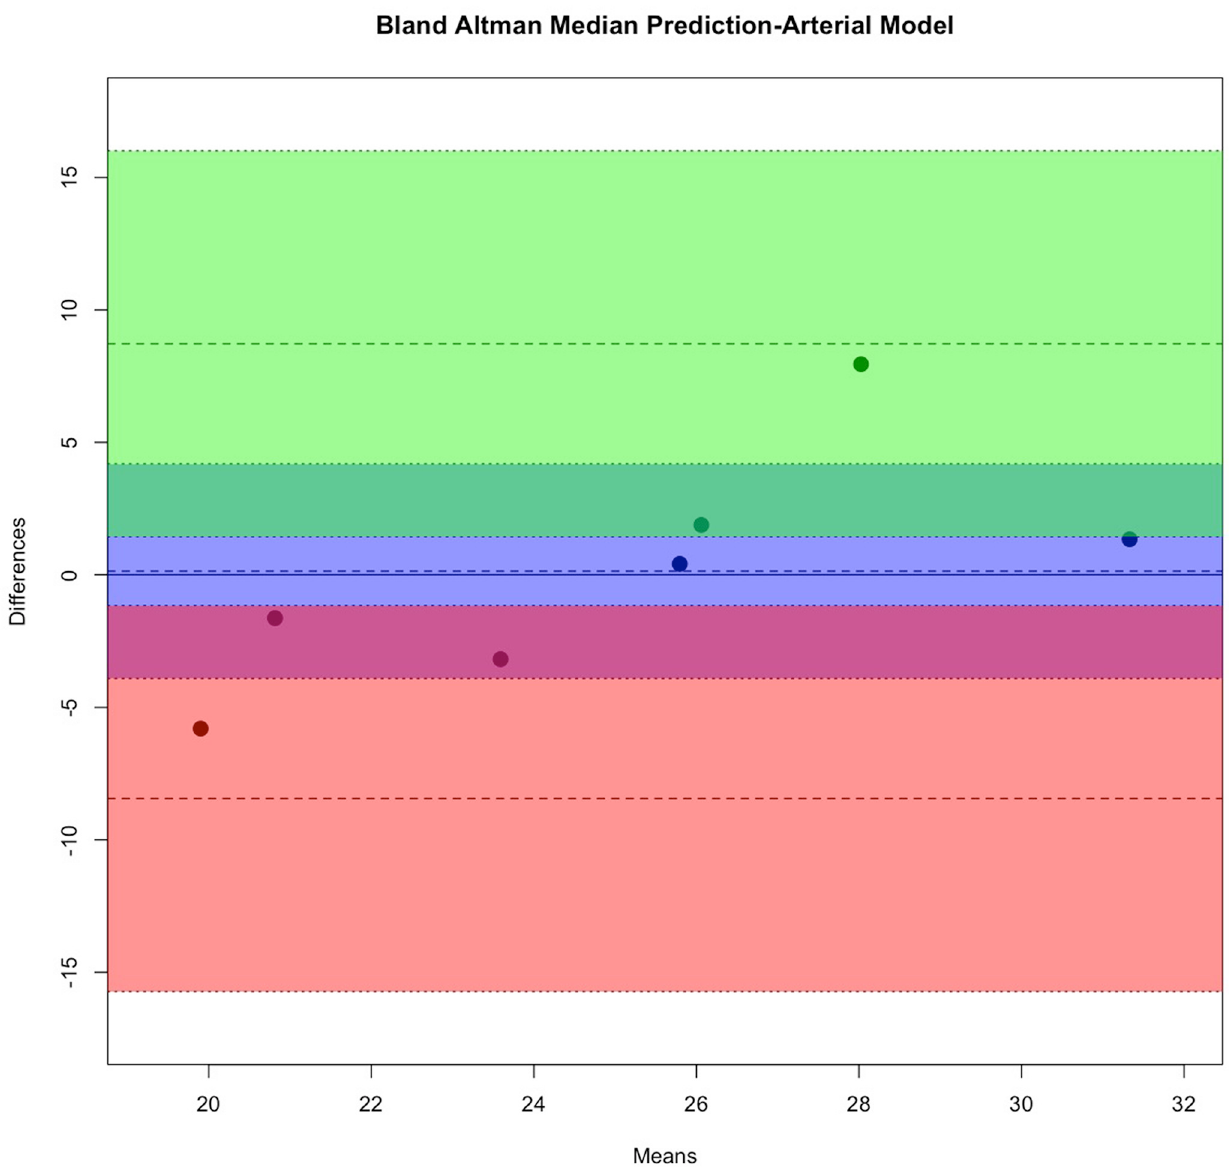
Fig 11. Bland-Altman plot predicted median predicted intracranial pressure of the arterial Extreme Gradient Boost model. The intervals of two standard deviations are considered as the concordance limits between the two measurements, accounting for 95% of the observed differences. The Bland- Altman bias was 0.139 ± 1.6545 cm water (p < 0.94), the arterial model provided a potential avenue for internal validation of the